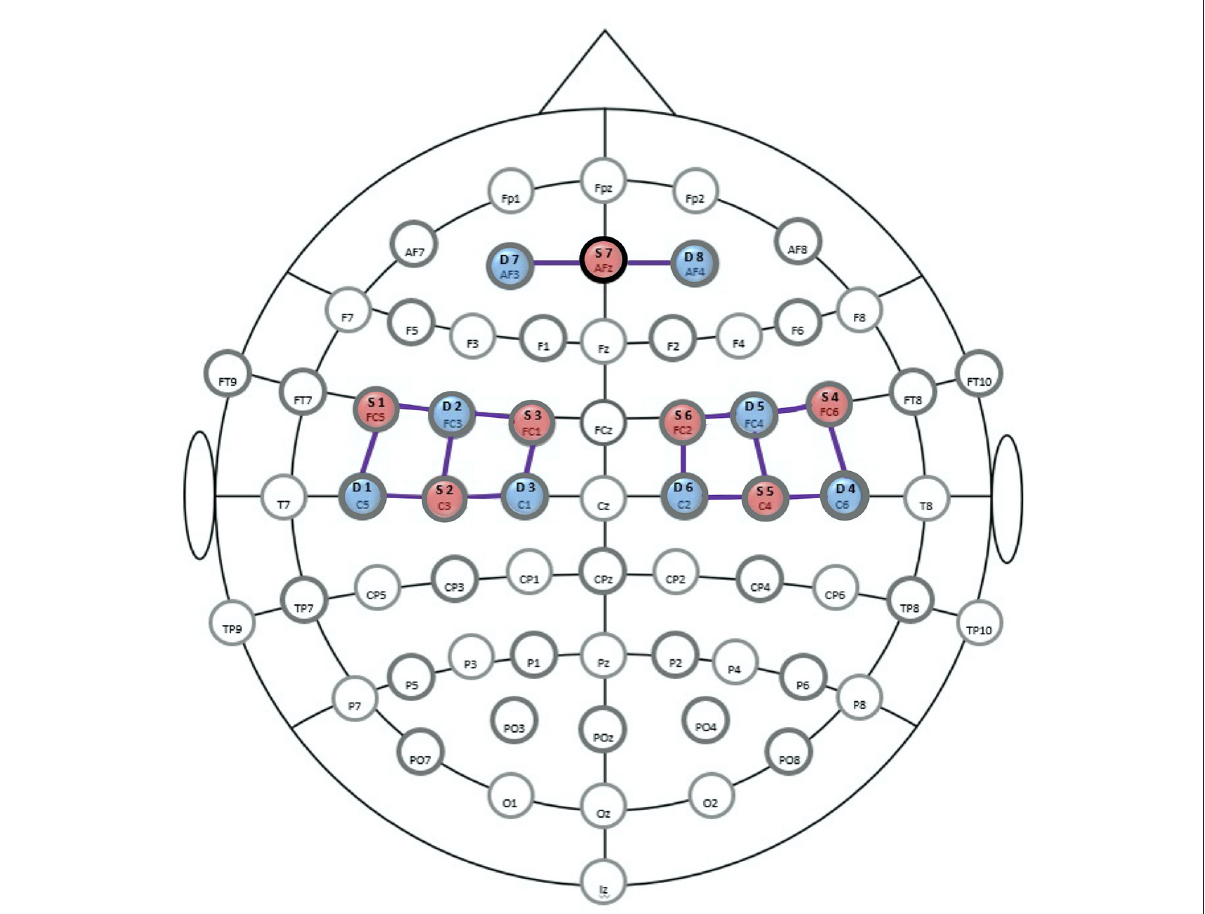
FIGURE2 Optode-setup for the near-infrared spectroscope (NIRS). Positions of the sources are shown in red (S1-7), those of the detectors in blue (D1-8). Long channels (LDC) are marked as connecting lines. Positions of the extended 10/20 EEG system are shown as landmarks for orientation. F, frontal; T, temporal; O, occipital; C, central; Iz, inion (central). Source: Figure generated from a NIRx-template